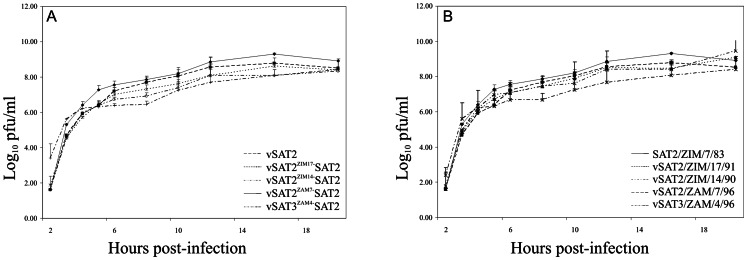
One-step growth kinetic studies were performed in BHK-21 cells.The average log virus titers are shown at different times p.i. with the vSAT2, vSAT2ZIM17-SAT2, vSAT2ZIM14-SAT2, vSAT2ZAM7-SAT2 and vSAT3ZAM4-SAT2 viruses (A) and the parental SAT2 and SAT3 viruses (B). For comparison of the relative release of virus particles from cells infected with the parental and chimeric viruses, the average virus titers were determined at different times p.i (2, 4, 6, 8, 10, 12, 16 and 20 h). The standard deviations of the titers determined from quadruple wells are indicated on the graph.